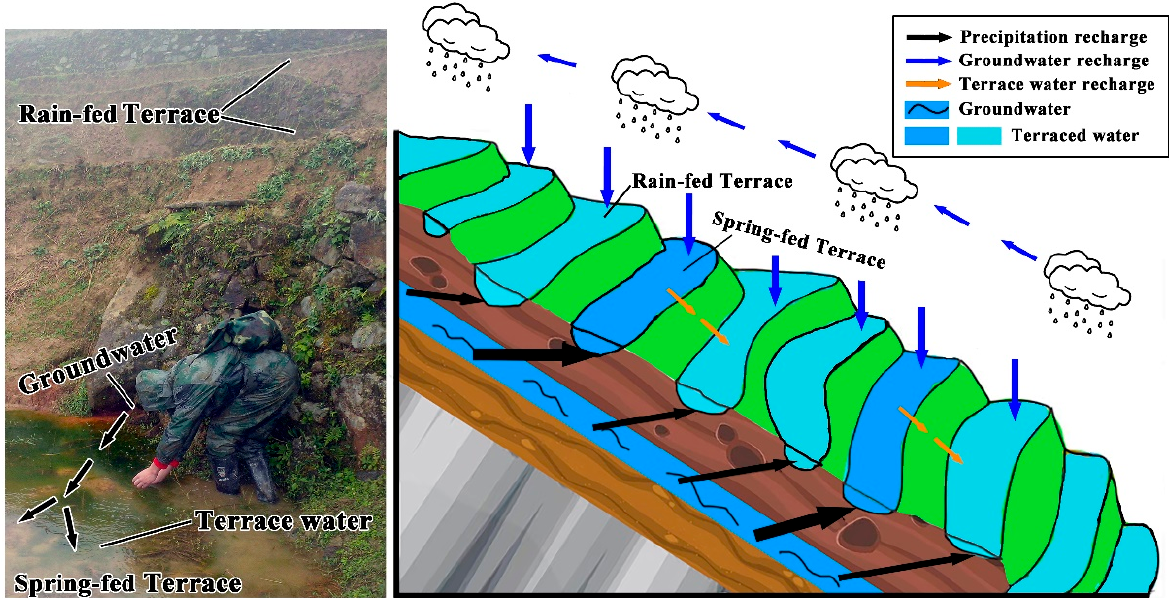
Figure 8. Spatial feature on terraced water under the influence of recharge.